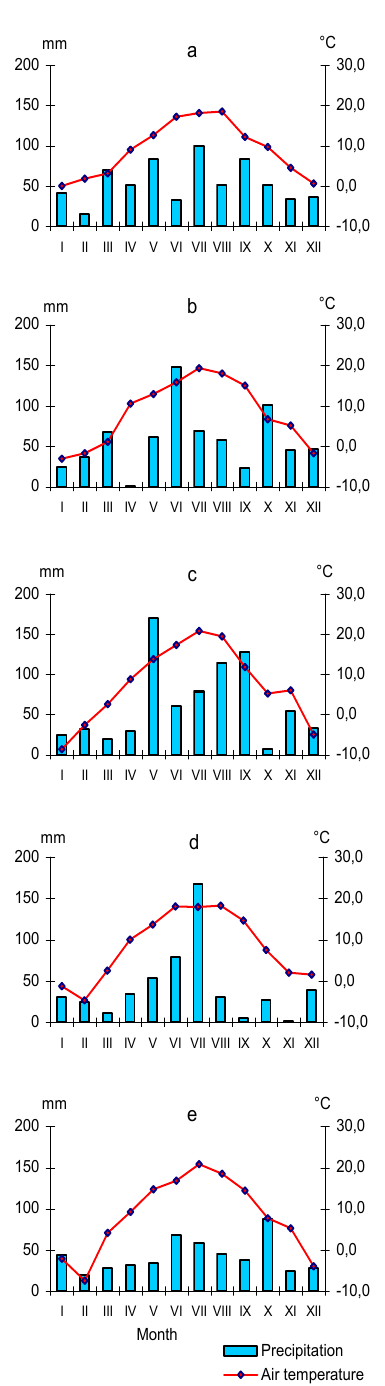
Figure 1. The average monthly air temperature and precipitation during the years of the experiment ( a – e ) and months of the research (I–V).